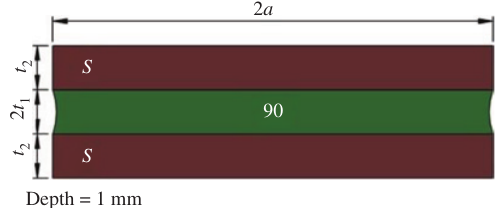
Figure 2: Cracked laminate in the rotated